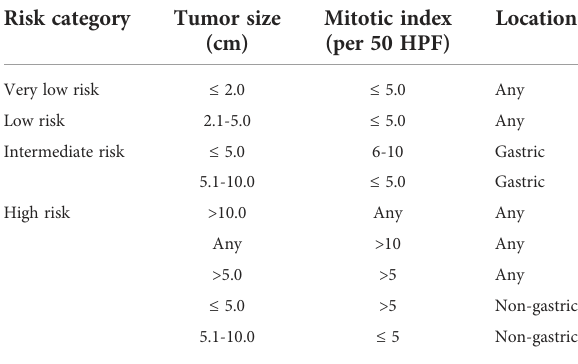
TABLE 1 NIH 2008 criteria for risk strati fi cation of GIST recurrence after